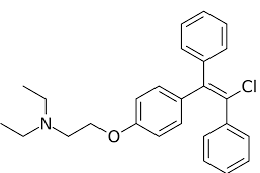
Figure 8. Chemical structure of clomiphene. Formula: C 26 H 28 ClNO.